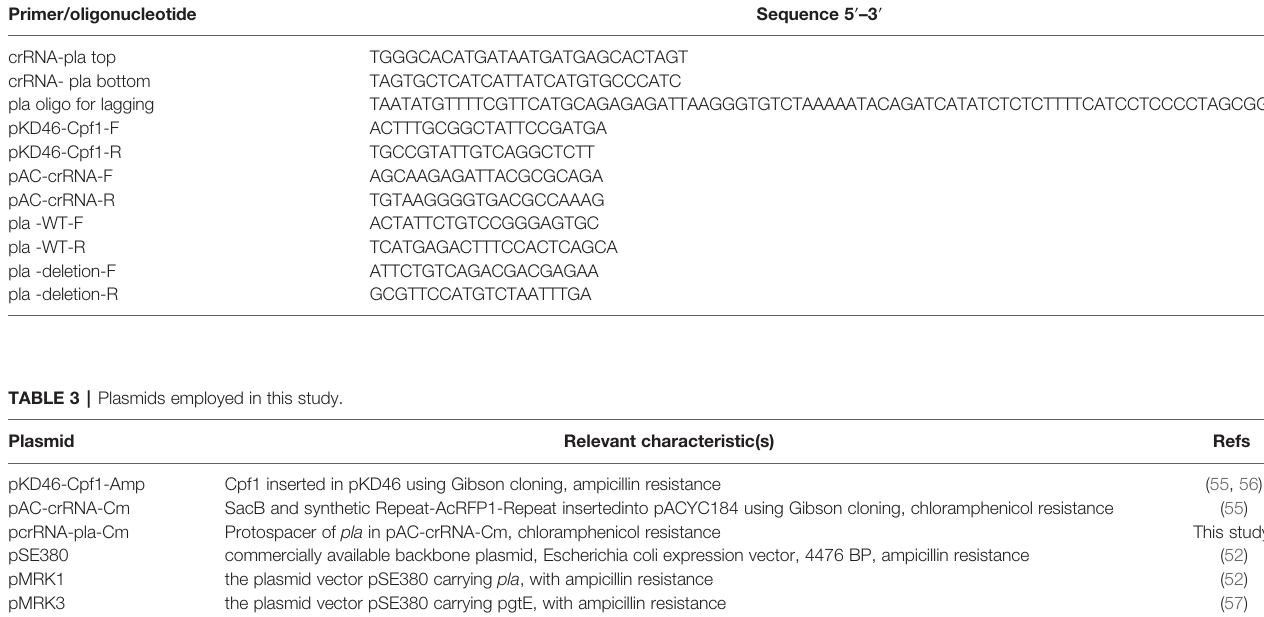
TABLE 2 | Primers and oligonucleotides used in this study. Primer/oligonucleotide